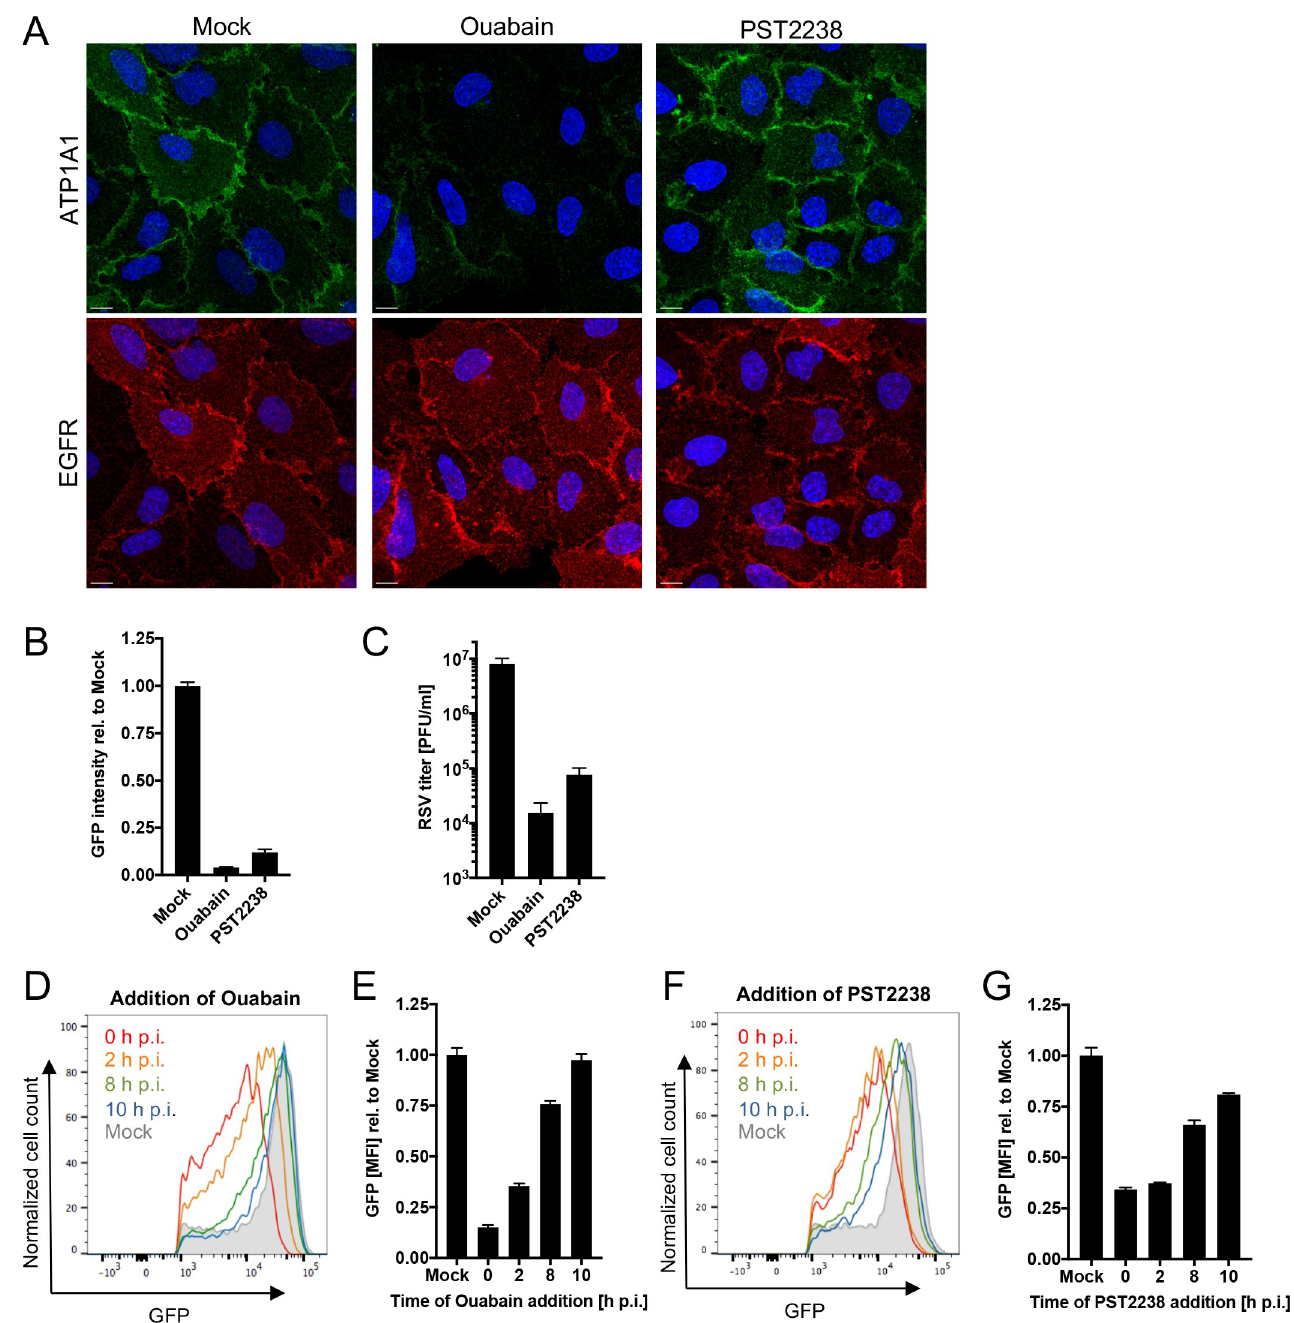
Fig 5. Effect of ouabain and PST2238 on RSV infection. (A) ATP1A1 and EGFR expression in A549 cells treated with Ouabain or PST2238. Uninfected A549 cells were treated for 24 h with either 25 nM ouabain or 20 μ M PST2238 and subjected to an immunofluorescence staining. ATP1A1 (green) was detected by an anti-ATP1A1 rabbit MAb (ab76020) and an AF488-conjugated donkey anti-rabbit secondary antibody. EGFR (red) was detected by an anti-EGFR rat MAb (ab231) and an AF647-conjugated goat anti-rat secondary antibody. The cell nuclei were stained with DAPI (blue). Scale bar 10 μ m. (B and C) Inhibitory effect on RSV infection. A549 cells pre-treated for 16 h with either 25 nM ouabain or 20 μ M PST2238 were inoculated with RSV-GFP (MOI = 1 PFU/cell). Cells were incubated for 17 h and infectivity was quantified by: (B) GFP signal of the total well, scanned by an ELISA reader and reported relative to mock- treated infected cells as 1.0; and (C) virus titer determined by plaque titration on Vero cells 24 h p.i. (D—G) Time-of-drug-addition experiment. A549 cells infected with RSV-GFP (MOI = 3 PFU/cell) were changed to medium containing 25 nM ouabain (D, E) or 20 μ M PST2238 (F, G) at the indicated times post infection. Cells were harvested 24 h p.i. and GFP intensity was quantified by flow cytometry of live, single, GFP+ cells. The MFI of GFP+ cells was quantified and expressed relative to mock-treated, RSV-infected cells (E, G).